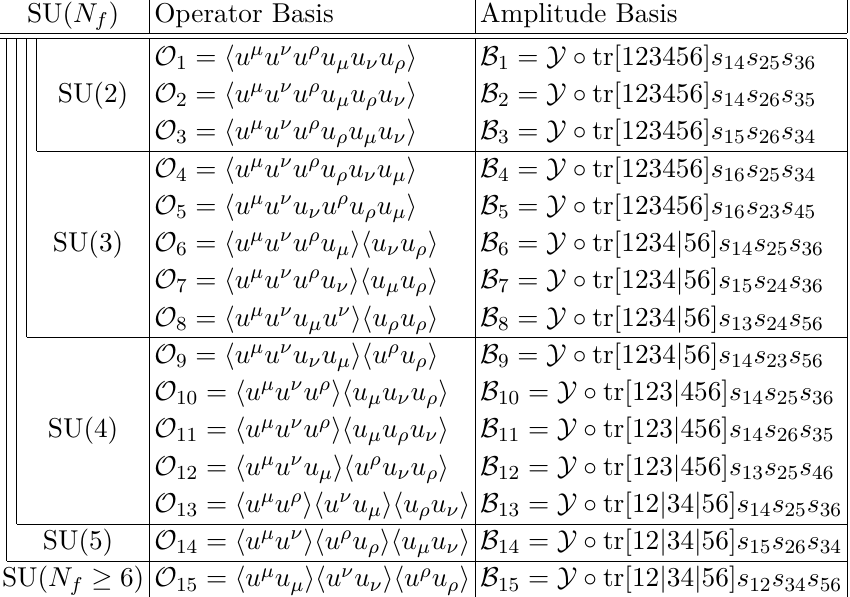
Table 9 . Independent 6-point soft basis for parity even at order O ( p 6 ) . We show explicitly how the amplitude basis becomes linearly redundant when N are also given in terms of building block u